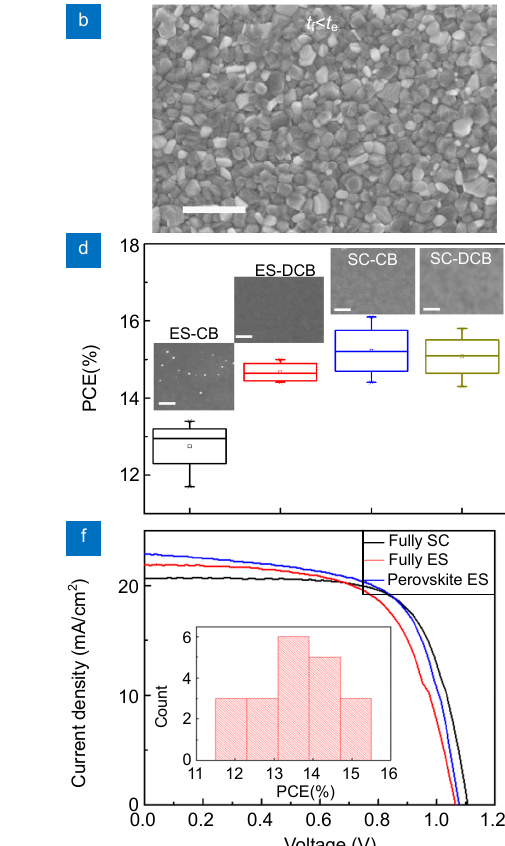
printed and spin-coated devices. Inset: top-view and cross-sectional SEM images of TiO 2 films electrospray printed at h =4, 3, 2 mm and